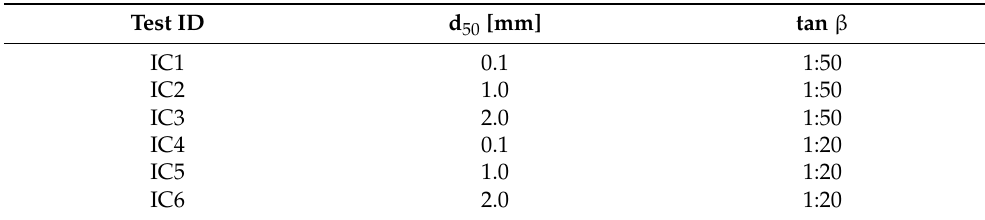
Table 2. Examined scenarios and combinations of the considered values of d 50 and tan β